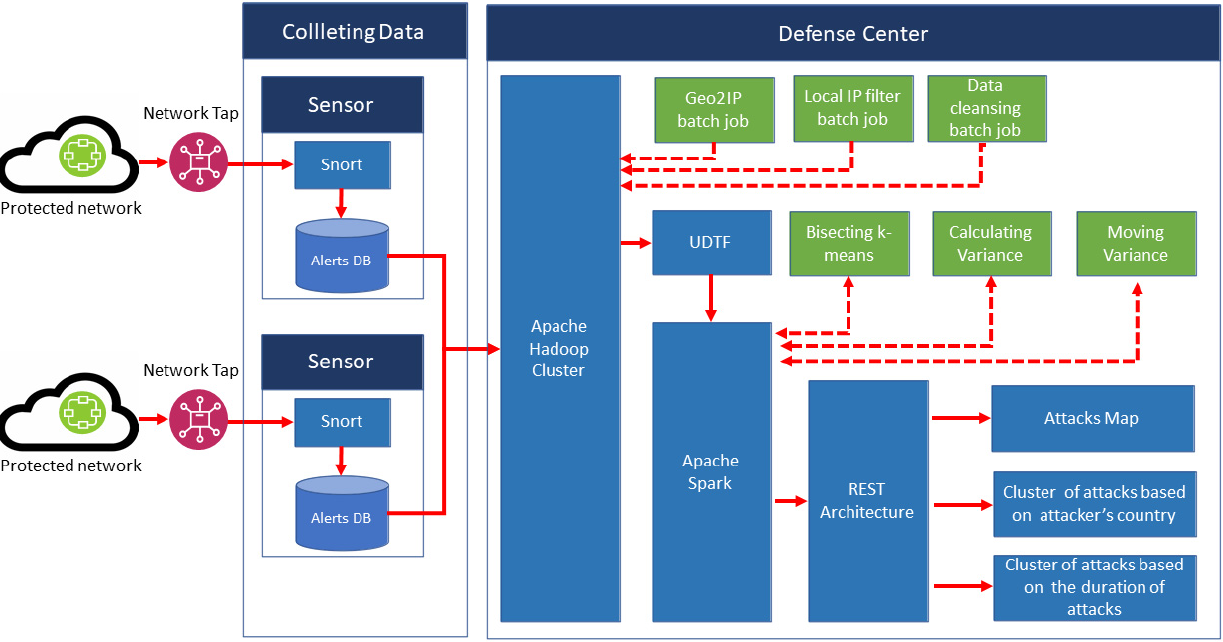
Figure 3. The improved version of Mata Garuda was based on big data technology.